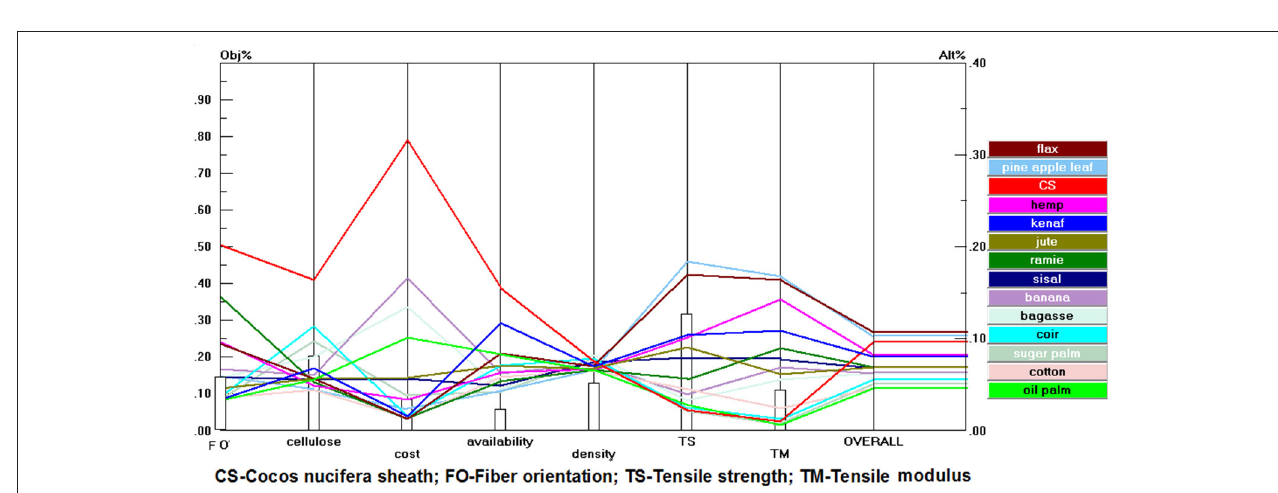
FIGURE 10 | Sensitivity graph of criteria with respect to goal when the priority vector of tensile strength is increased by 20%